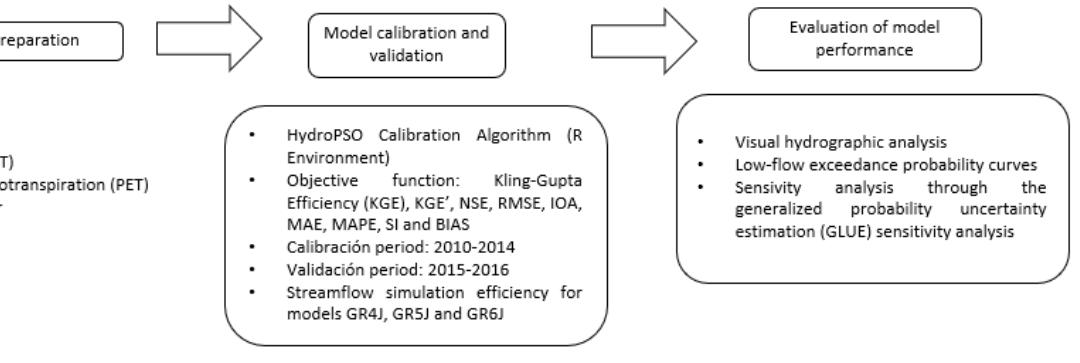
Figure 4. Methodology flow chart.